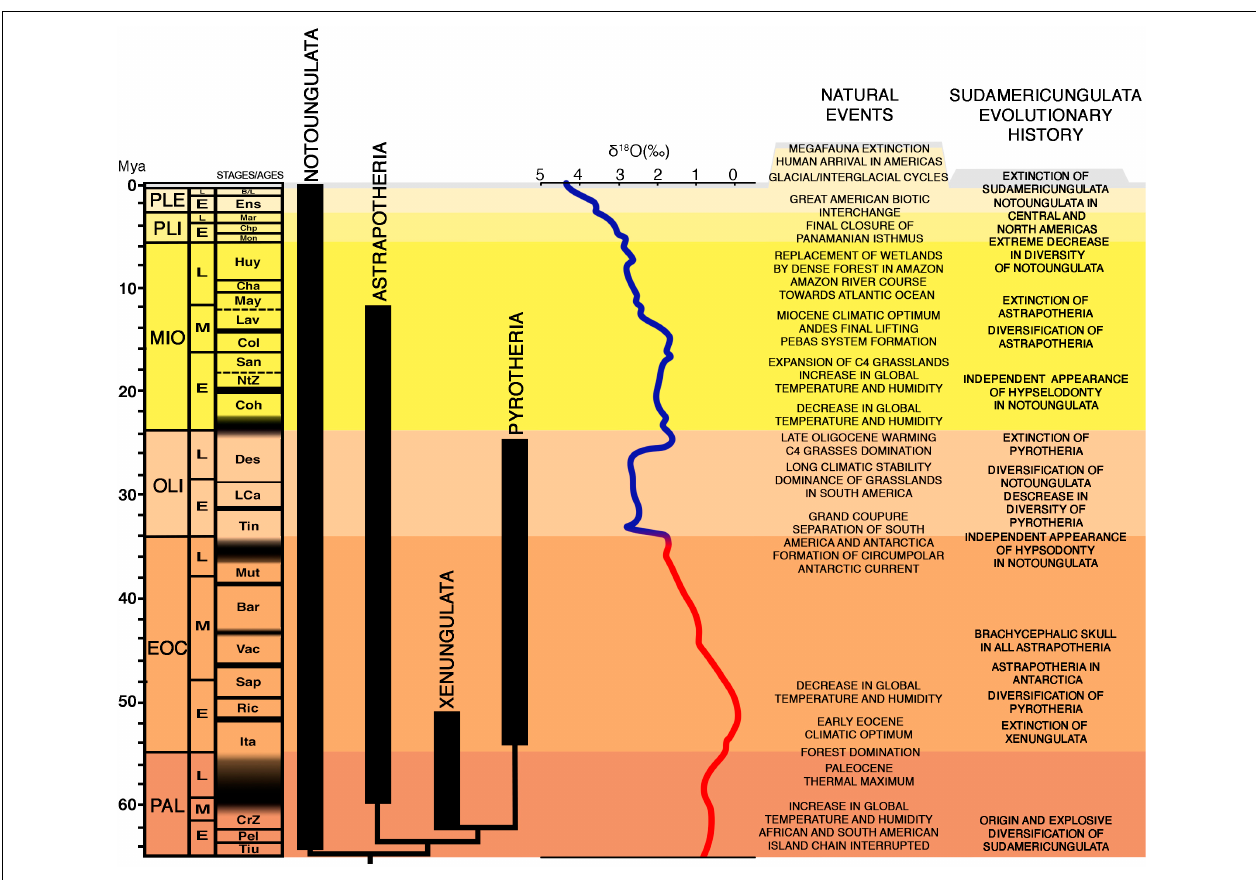
FIGURE 3 | Interrelationships of the Sudamericungulata lineages and its evolutionary history. Phylogeny of Sudamericungulata calibrated by South American Stages/Ages: Tiu (Tiupampan), Pel (Peligran), CrZ (“Carodnia Zone”), Ita (Itaboraian), Ric (Riochican), Sap (“Sapoan”), Vac (Vacan), Bar (Barrancan), Mut (Mustersan), Tin (Tinguirirican), LCa (“La Cantera Fauna”), Des (Deseadan), Coh (Colhuehuapian), NtZ (“Notohippus Zone”), San (Santacrucian), Col (Colloncuran), Lav (Laventan), May (Mayoan), Cha (Chasicoan), Huy (Huayquerian), Mon (Monteherosan), Chp (Chapadmalalan), Mar (Marplatan), Ens (Ensenadan), B (Bonaerian), and L (Lujanian), modified from Croft (2016). The Zachos curve during Cenozoic is represented by the red and blue lines. The red portion represents the “Hot House World” when global temperature and humidity had a high average, while the blue portion represents the “Ice House World,” when global temperature and humidity had a low average (Zachos et al.,